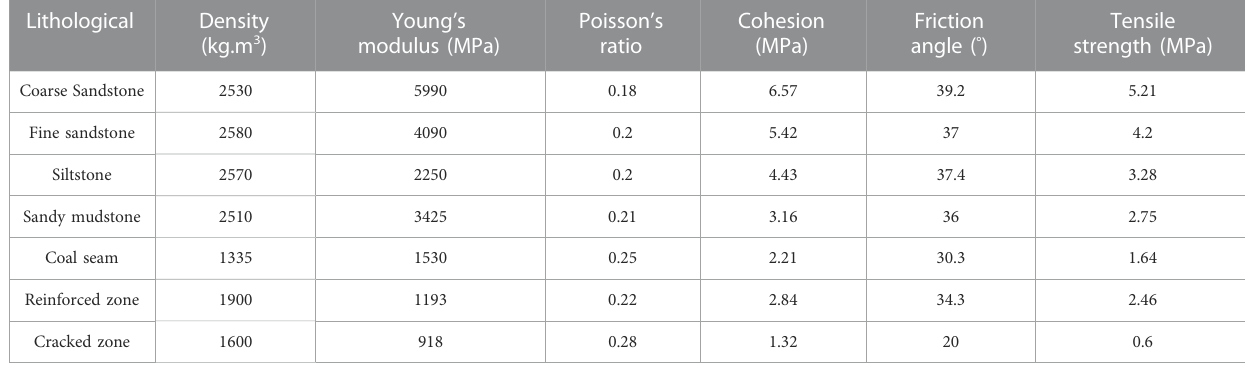
TABLE 1 Physico-mechanical parameters of rock mass near the I01023